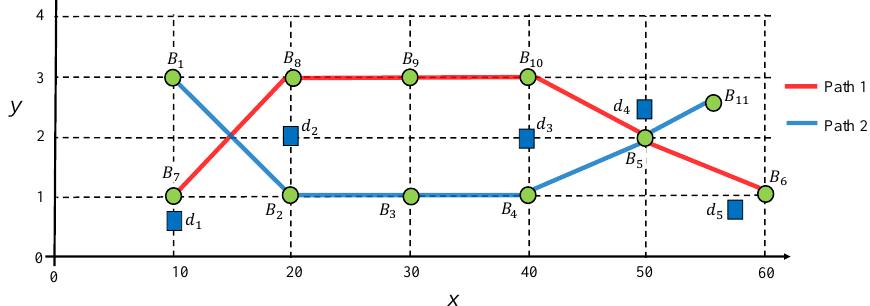
Figure 3. Remote drivers and base stations in a remote driving